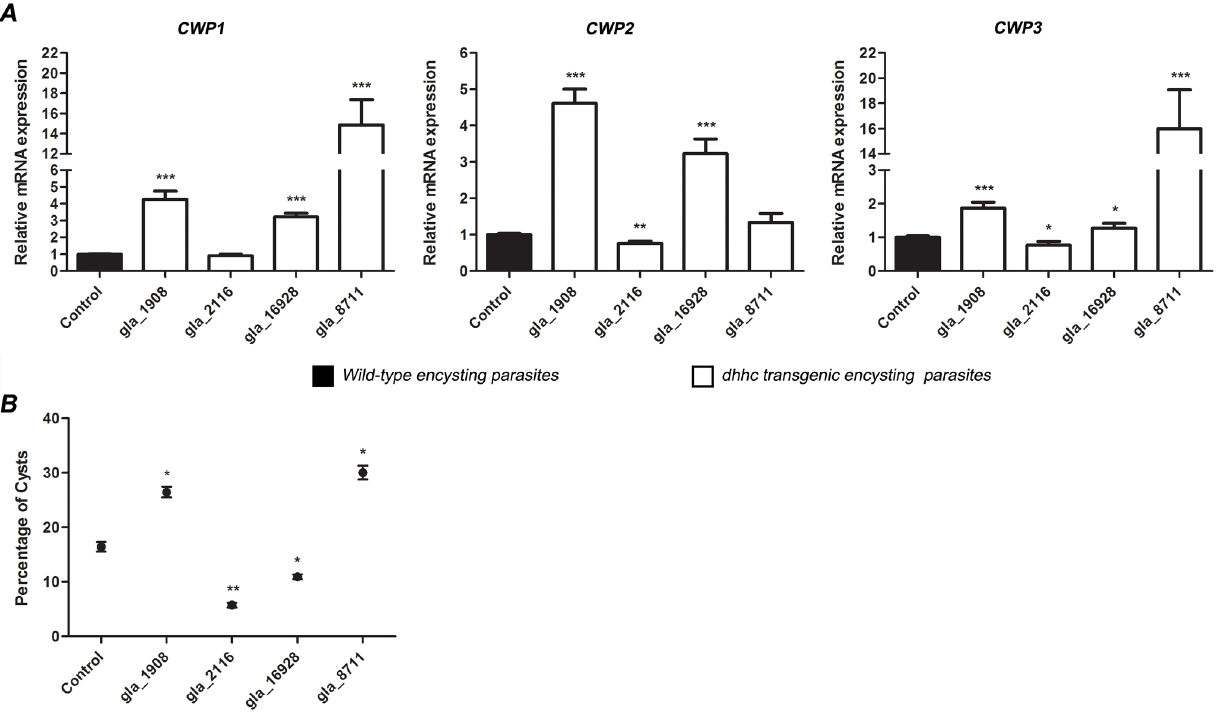
Figure 9. The expression of cyst wall protein transcripts and the amount of cysts are different among dhhc transgenic encysting parasites. (A) qRT-PCR analysis of cwp1, cwp2 , and cwp3 transcripts expression in dhhc transgenic parasites after 48 h of encystation (white bars), relative to the expression in wild-type encysting cells (control) (black bars). The data are the means and SEM of three separate experiments, and each experiment was carried out in triplicate. (B) Percentage of water-resistant cysts in dhhc transgenic parasites determined by flow cytometry after 48 h of encystation. The results are presented as the percentage (mean 6 SEM) of cysts in three independent experiments. The asterisks indicate that there was significant difference compared with the control (Student’s t test: * p , 0.05; **p , 0.01; ***p ,